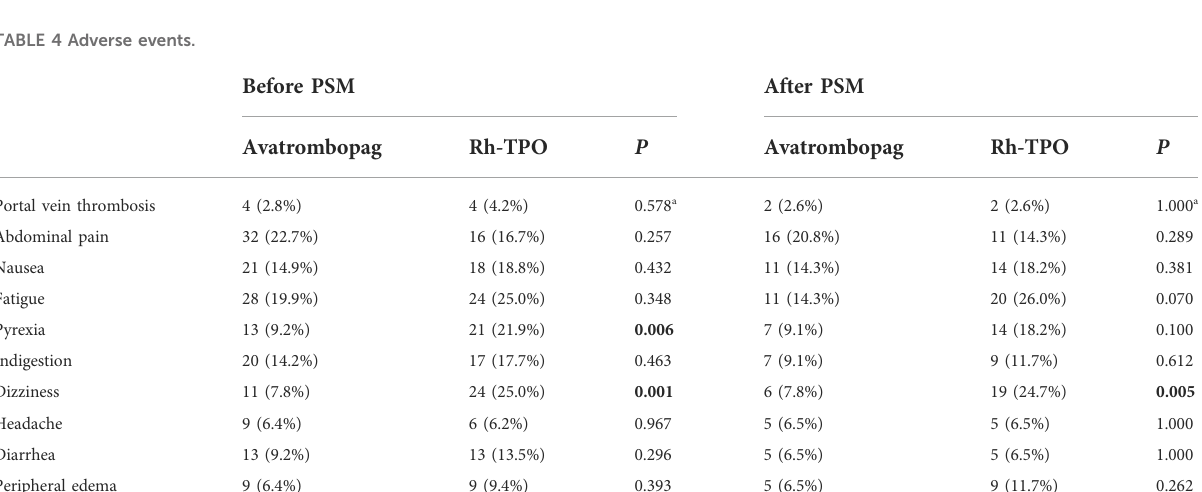
TABLE 4 Adverse